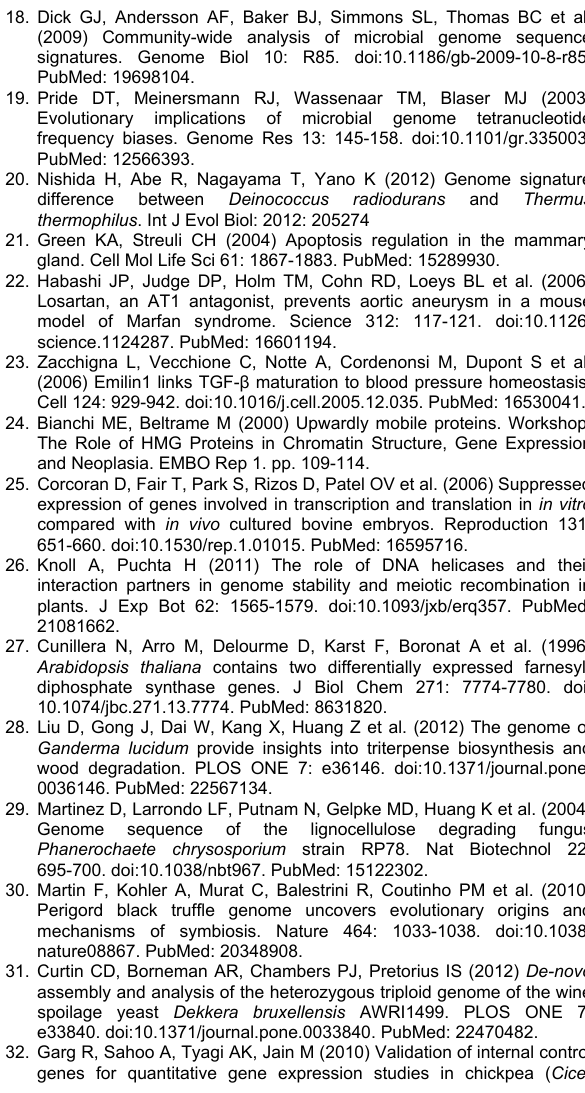
Table S2. Expression analysis based on reads per kilobase per million (RPKM) values and RT-PCR validation results.